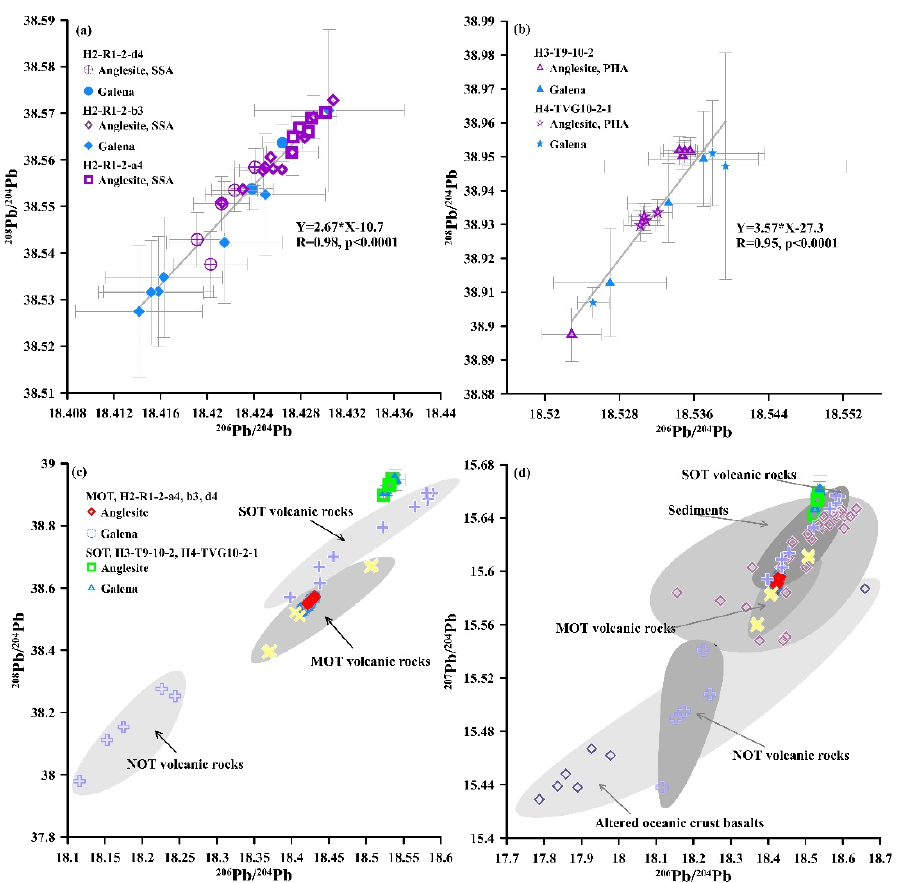
Figure 11. Plots of anglesite and galena in MOT (samples H2-R1-2-d4, b3, a4) and SOT (samples H3-T9-10-2, H4-TVG10-2-1): ( a – c ) 208 Pb/ 204 Pb vs. 206 Pb/ 204 Pb; ( d ) 207 Pb/ 204 Pb vs. 206 Pb/ 204 Pb. PHA—primary hydrothermal anglesite; SSA—secondary supergene anglesite. Data for NOT, MOT and SOT volcanic rock, sediment and altered oceanic crust basalt from Shu et al. [68].